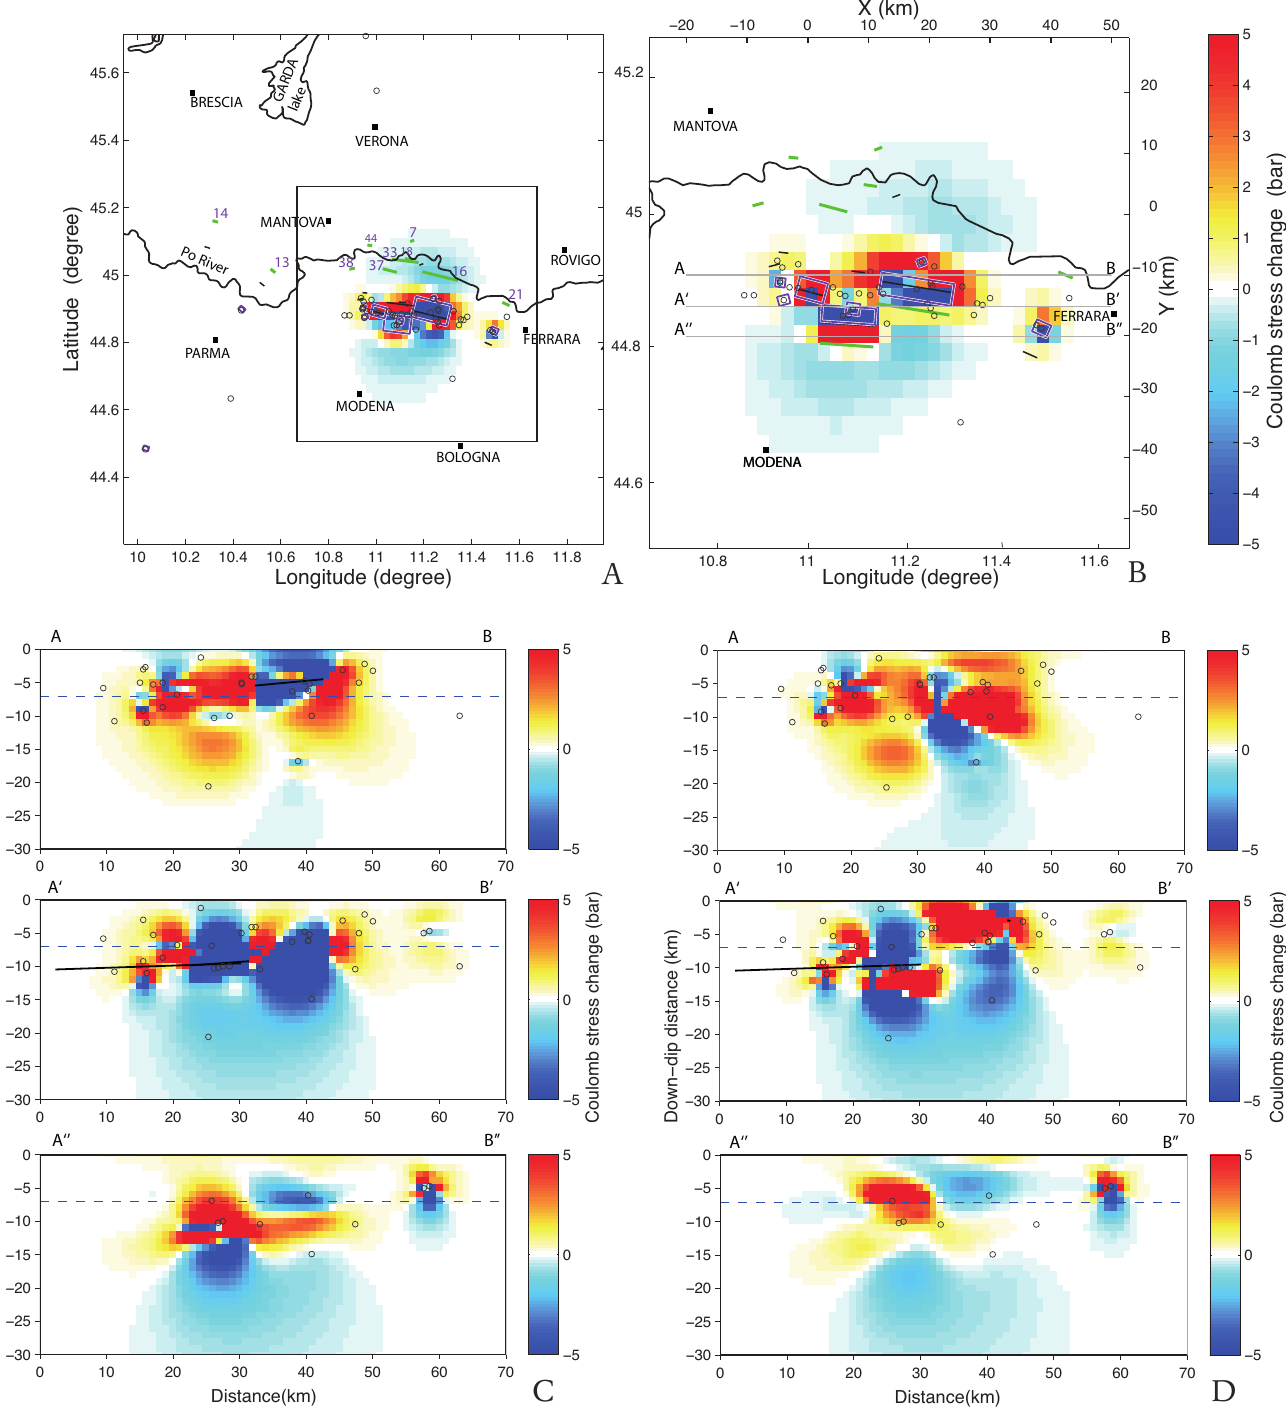
Figure 3. Coulomb stress change analyses in the Po Plain hit by the Emilia 2012 sequence. A. Coulomb stress change map at 7 km depth, with the fault model given by 10 S-dipping sources. Pink rectangles, ruptures; numbers of the source, written beside the hypothetical intersection of the planes at the surface (green traits); small black circles, focal mechanism dataset. B. As for A), but sources No. 16 and 33 are modeled by N-dipping fault planes. C. Coulomb stress change profiles for the model of Figure 3A, with the position of the sections given in Figure 3B. D. As for (C), using the fault model of Figure 3B. Black sub-horizontal traits in some profiles, ruptures intersected by the profile (apparent